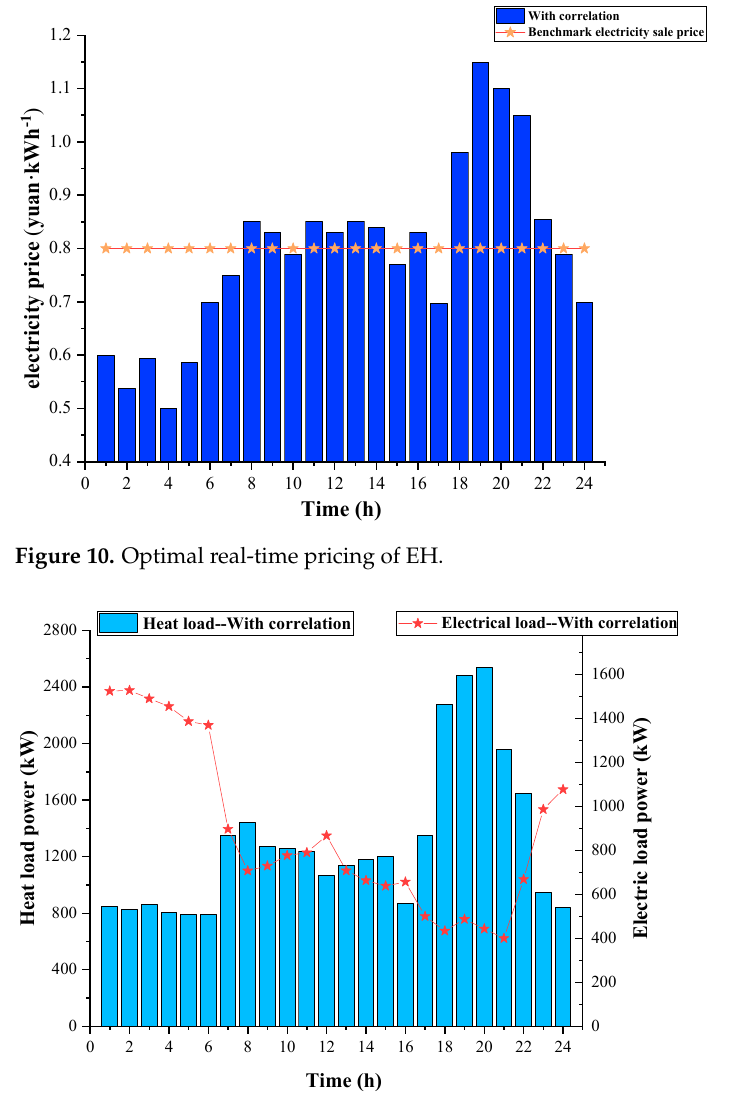
Figure 9. Thermal power balance.